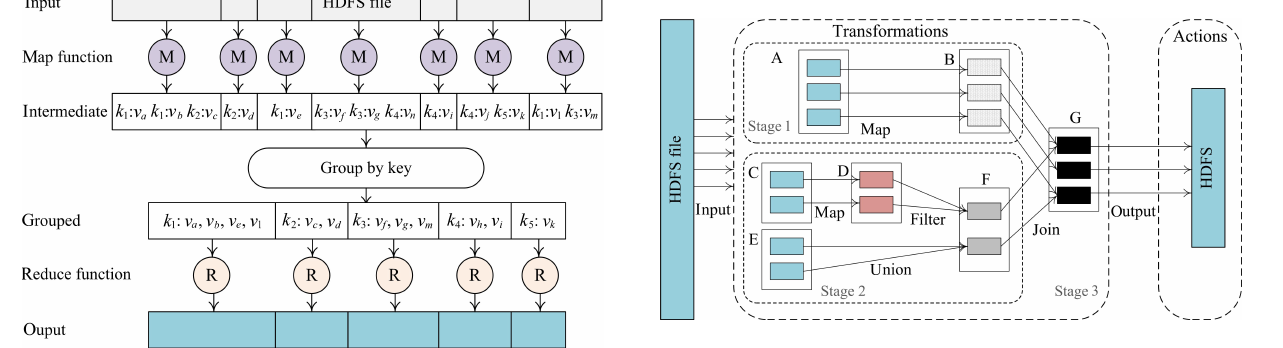
Fig. 2 Data sharing using Spark